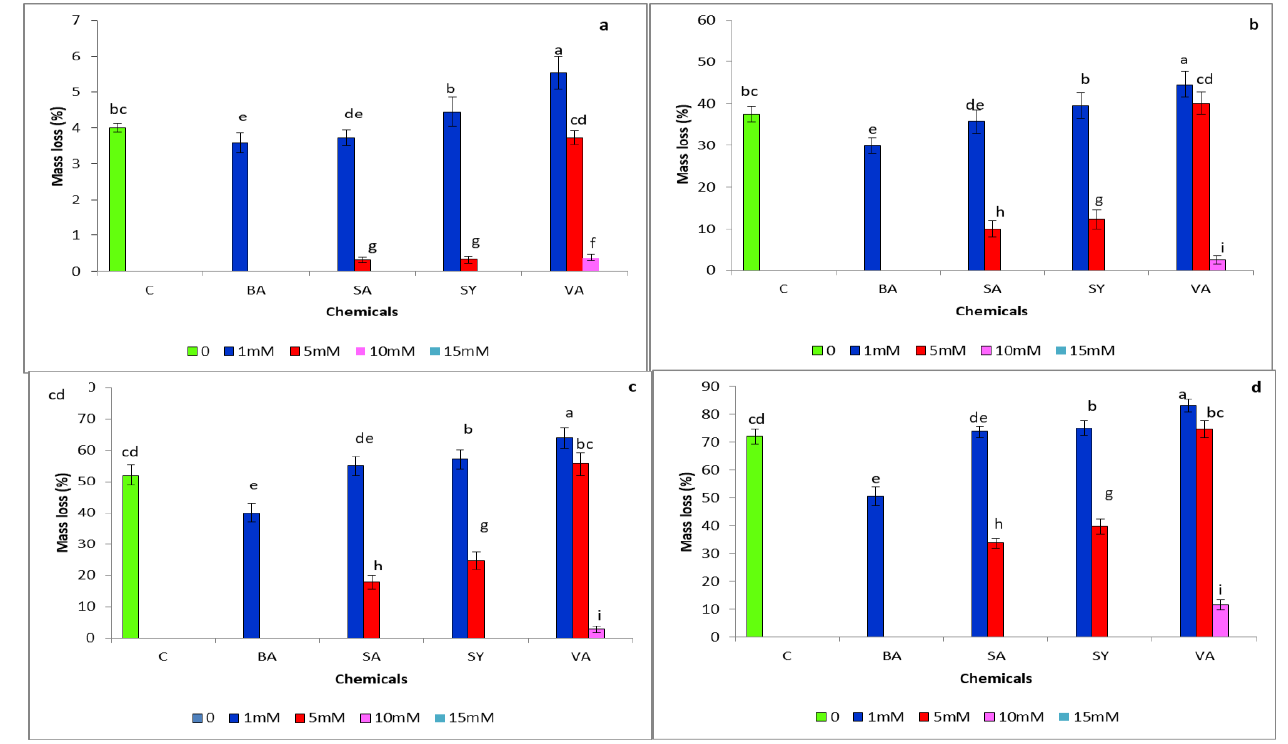
Figure 1. Degradation of oil palm wood by G. boninense with and without phenolic treatments at various time intervals. ( a ) 10th-day sampling of degraded oil palm wood; ( b ) 30th-day sampling of degraded oil palm wood; ( c ) 45th-day sampling of degraded oil palm wood; ( d ) 120th-day sampling of degraded oil palm wood. Vertical bars indicate standard deviation (S.D.) n = 6. C—control, BA—benzoic acid, SA—salicylic acid, SY—syringic acid and VA—vanillic acid. No data due to absolute inhibition for BA (5, 10 and 15 mM), SA (10 and 15 mM), SY (10 and 15 mM) and VA(15 mM).